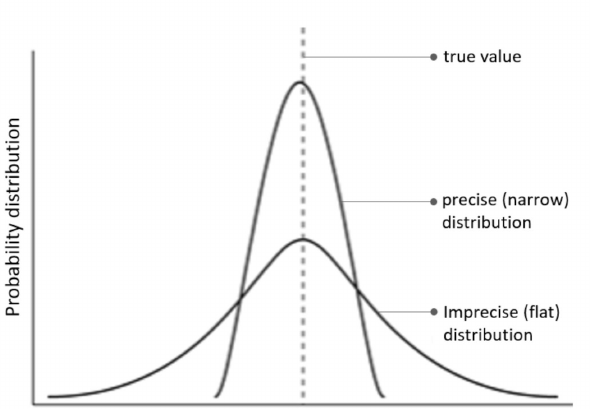
Figure 2. (precision) The figure plots two hypothetical probability distributions—one precise (narrow) and the other imprecise (flat).